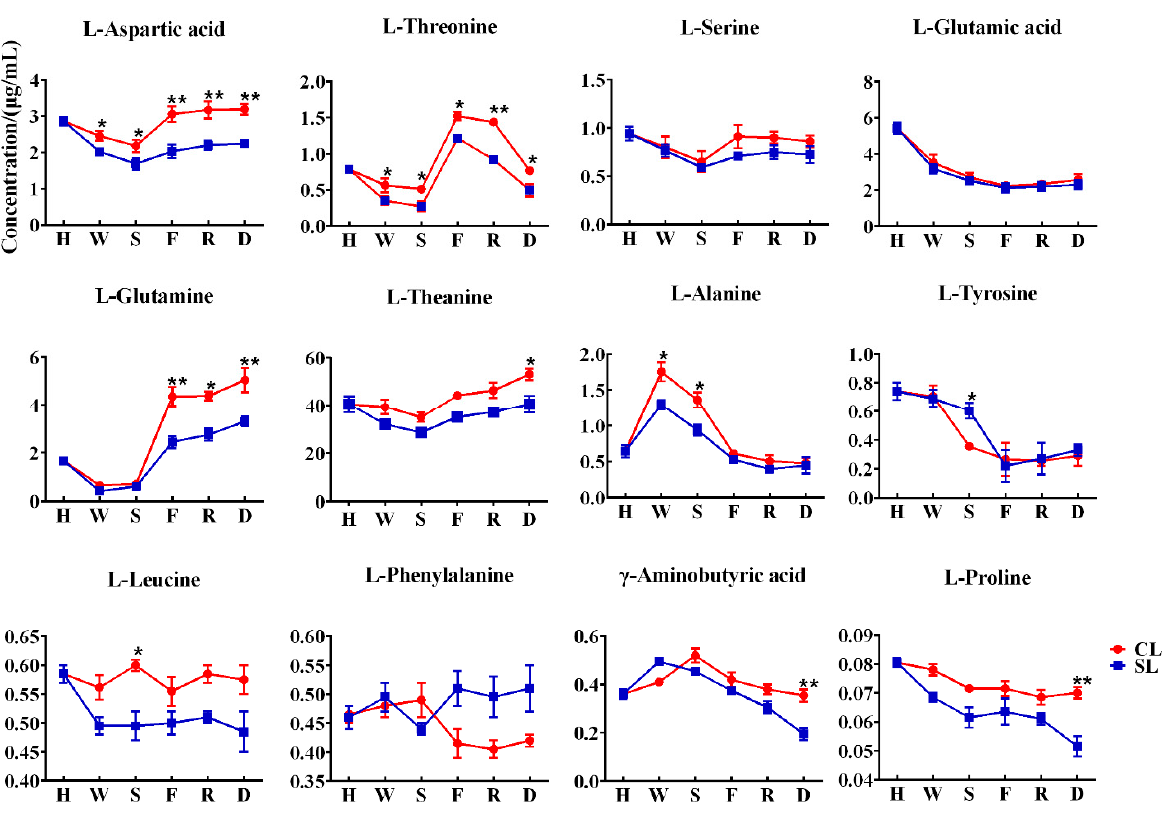
Figure 5. Dynamic changes of free amino acid content in leaves. H stands for harvesting, W stands for withering, S stands for shaking, F stands for firing, R stands for rolling, and D stands for drying (CL, combined leaf; SL, separated leaf; **, p < 0.01; *, p < 0.05).